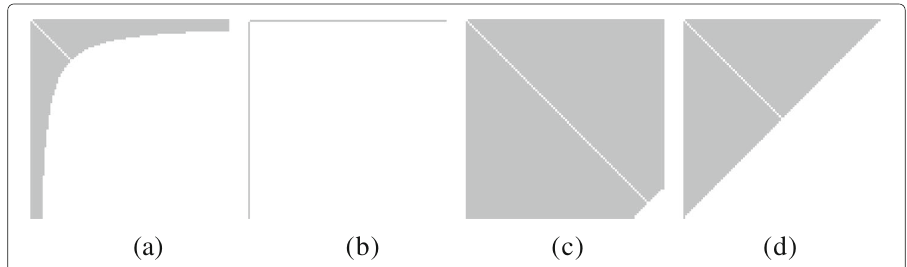
Fig. 3 Adjacency matrices of idealised hyperbolic communities. The different extremes of hyperbolic structures, range from star-like to near-clique. a 20%-core b star c near-clique d triangle